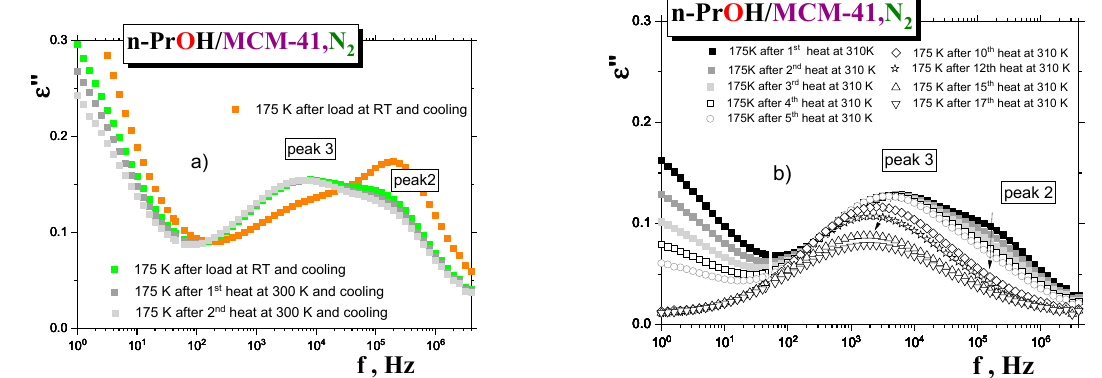
Figure 10. Spectral evolution of the originally saturated n-PrOH / MCM-41, N 2 system, after two heating-cooling cycles at 300 K ( a ) and after following seventeen-fold heating-cooling ones at 310 K ( b ). BDS spectrum for the overfilled sample is added for comparison.